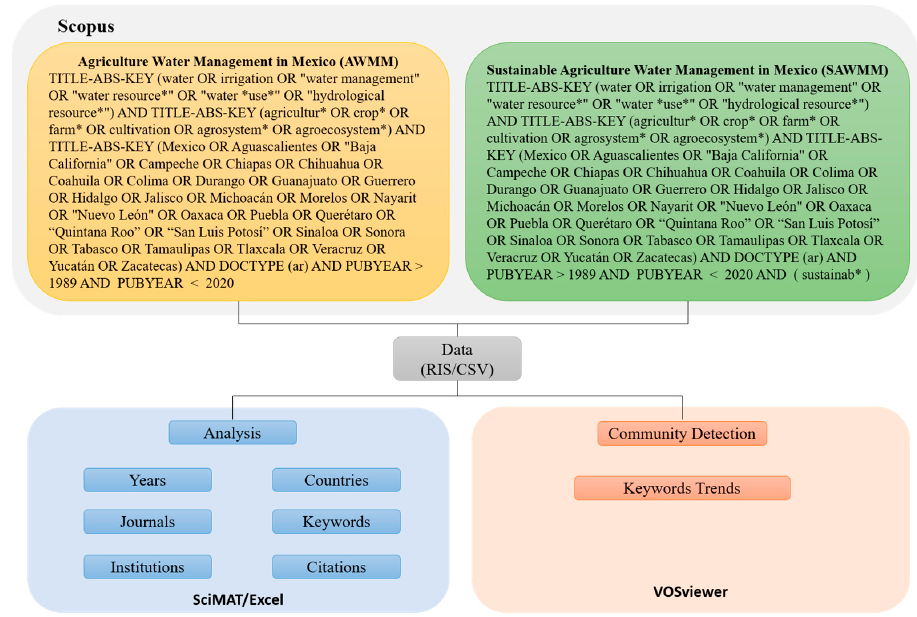
Figure 1. Summary of the methodology.